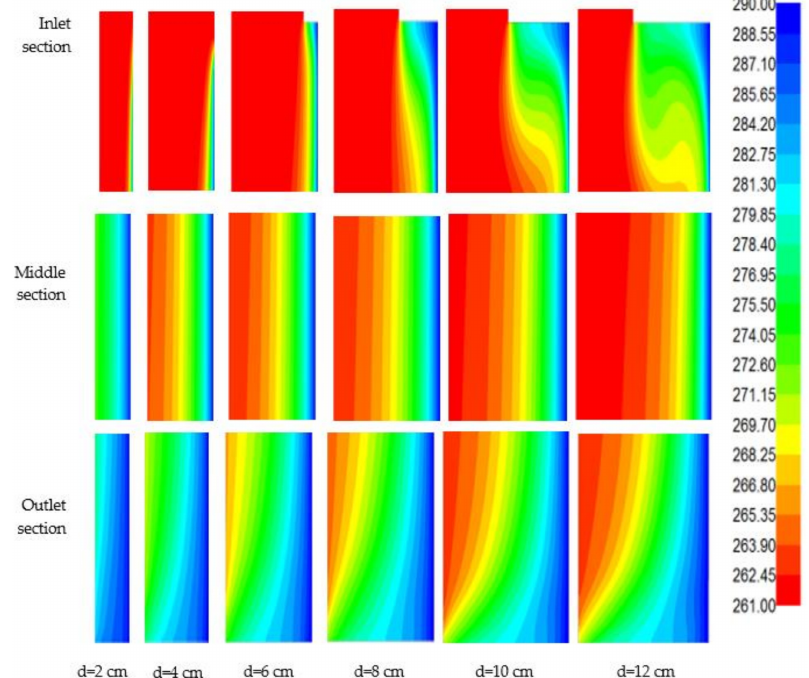
Figure 8. Temperature cloud of cavity variation with the thickness of air layer. (unit: K).